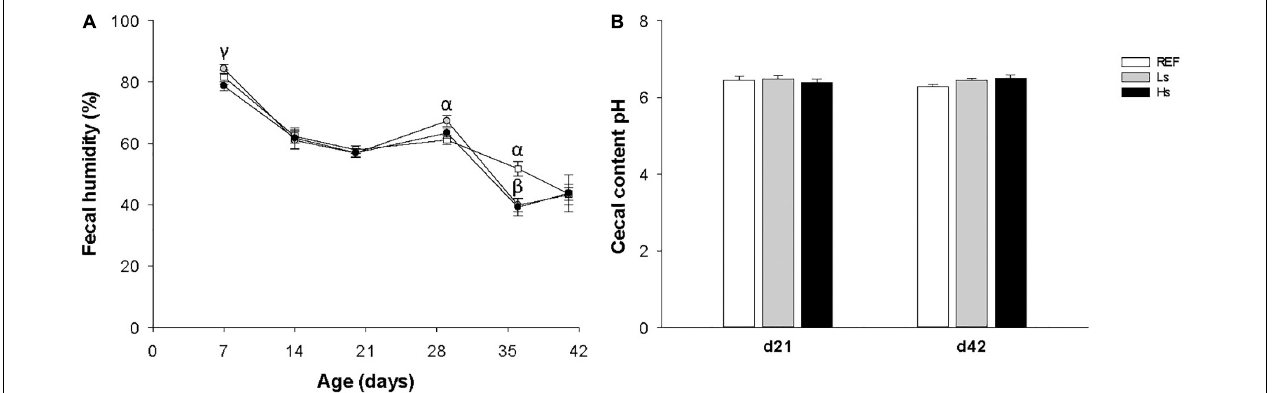
FIGURE 2 | Fecal humidity during the study (from days 7 to 42 of life) (A) and cecal content pH on day 21 (the end of the supplementation) and day 42 (3 weeks after the end of the supplementation) (B) . Results are expressed as mean ± SEM ( n = 12–24 animals/group). Statistical differences: α p < 0.05 Ls vs. REF, β p < 0.05 Hs vs. REF and γ p < 0.05 Hs vs. Ls. REF, reference group; Ls, group supplemented with low dose of S. epidermidis and Hs, group supplemented with high dose of S. epidermidis